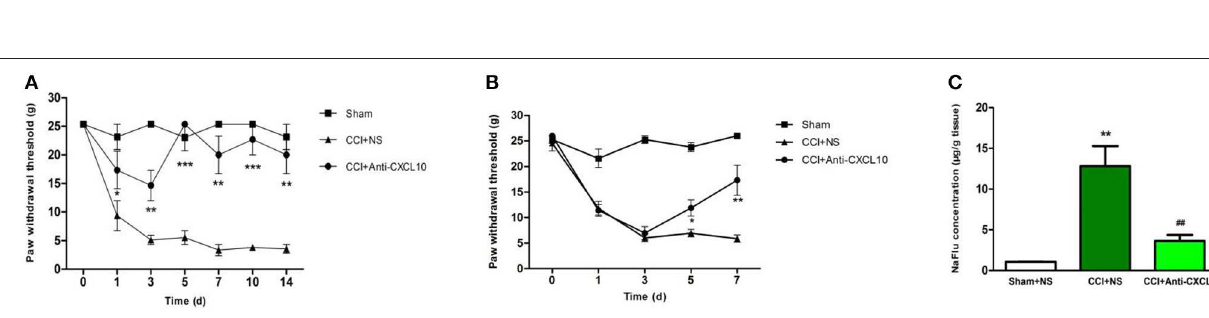
Frontiers in Immunology |